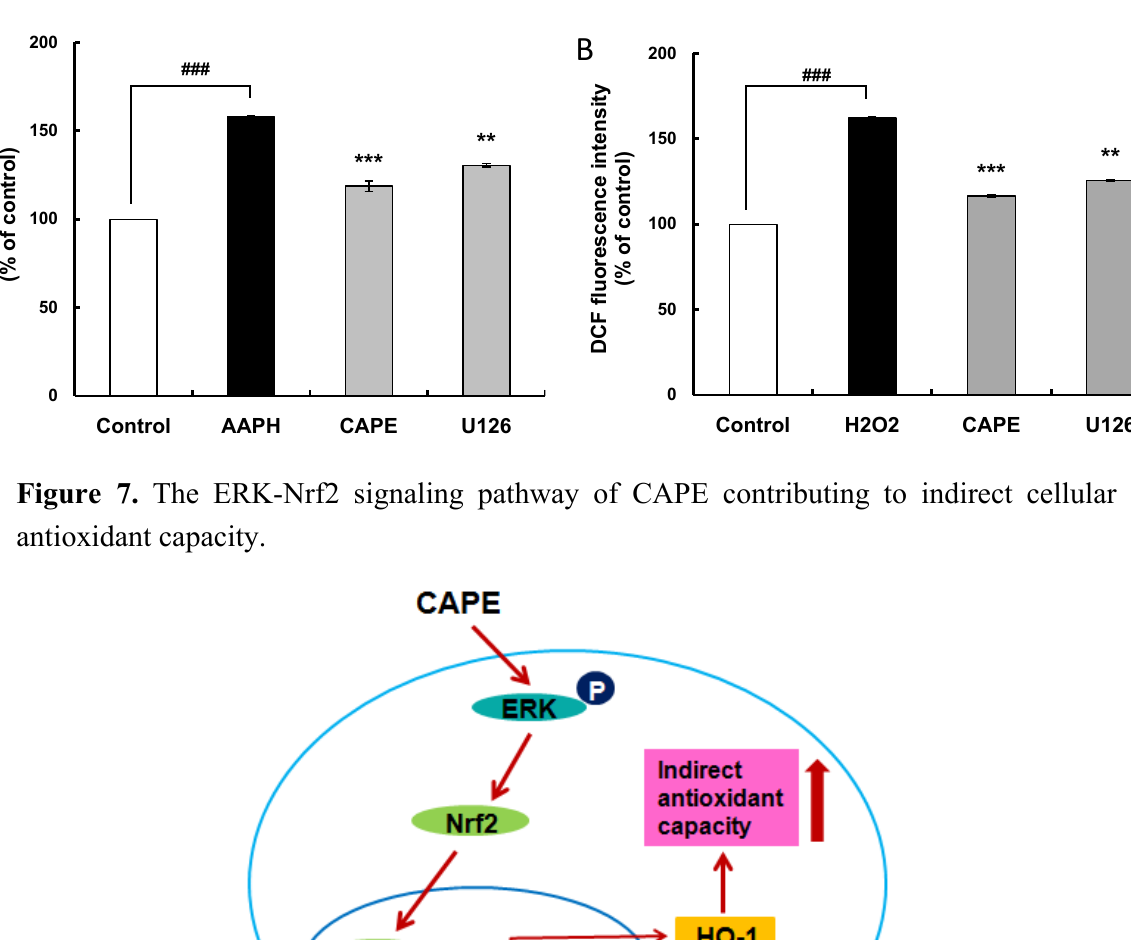
depicted in Figure 7; however, further investigation is required to elucidate precisely the molecular signaling mechanisms involved in the indirect antioxidant capacity of CAPE in HepG2 cells. Figure 6. Cellular antioxidant capacity of CAPE against oxidative stress induced by AAPH (2,2'-azobis (2-amidinopropane) dihydrochloride) or H O requires HO-1 induction 2 2 through ERK activation ( A , B ). After HepG2 cells were first cultured in 96-well plates (5 × 10 5 /mL) with Dulbecco’s modified Eagle’s medium (DMEM) for 24 h, they were sequentially pre-incubated with 10 μM U126 for 30 min and 20 μM CAPE for 30 min and exposed to 60 μM AAPH or 1 mM H O for 30 min. After HepG2 cells were then treated 2 2 with 40 µM DCFH-DA (2',7'-dichlorodihyrofluorescein-diacetate) for 30 min in the dark, the cells were washed with Hank’s balanced salt solution (HBSS) and 2',7'-dichlorofluorescein (DCF), fluorescence intensity was measured at an excitation wavelength of 485 nm and an emission wavelength of 535 nm using a Tecan GENios fluorometric plate reader (Salzburg, Austria). Data are expressed as percentages of the value of untreated cells (mean ± standard deviation, n = 3), ### p <0.001 vs. control, *** p <0.001 vs. AAPH, ** p <0.01 vs. AAPH.